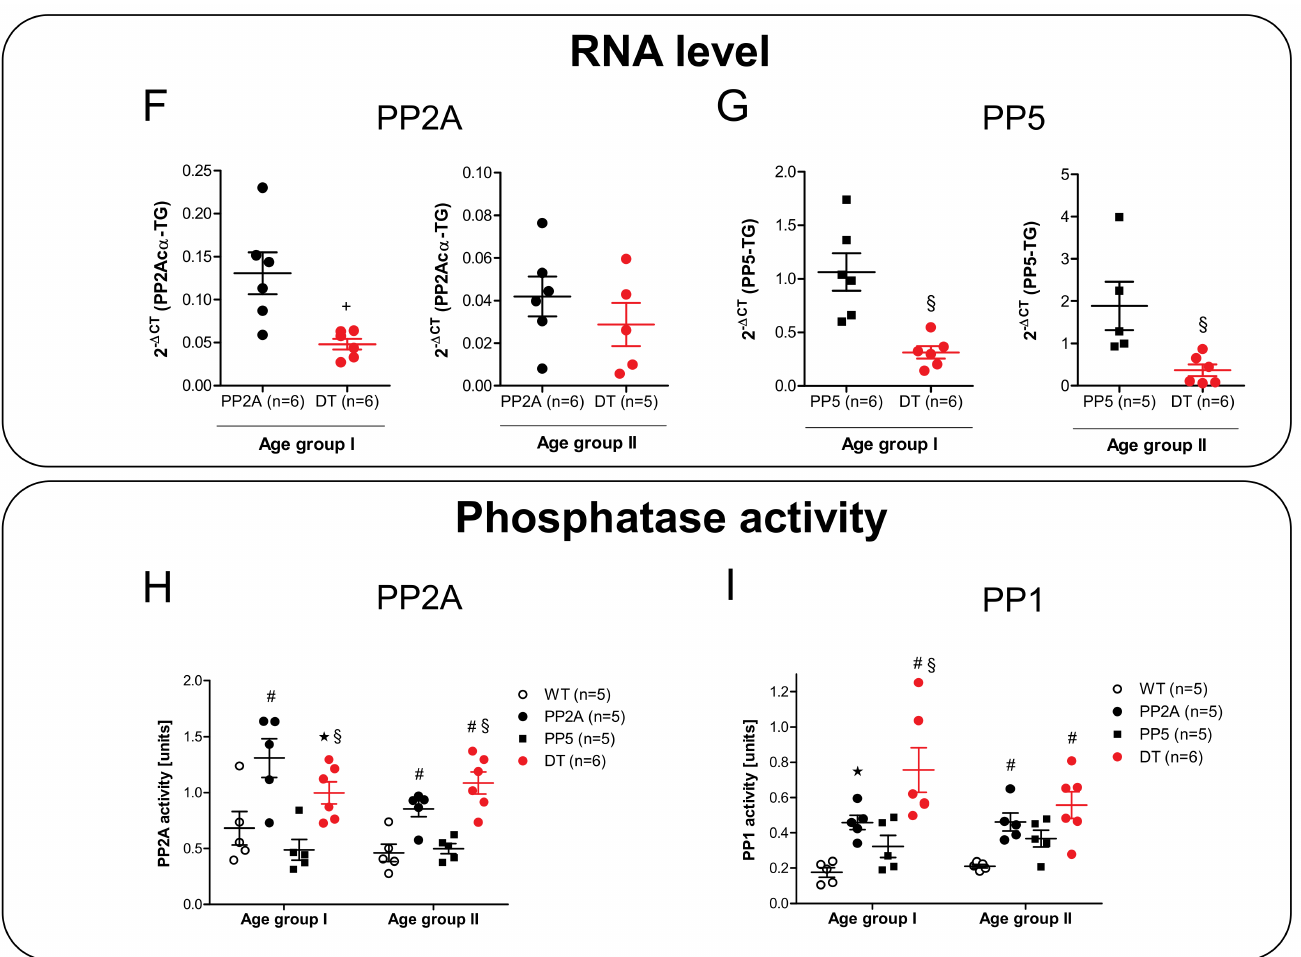
Figure 4. Protein expression of PP2Ac and PP5 in ventricles and left atria of young (age group I) and middle-age (age group II) mice. ( A ): Typical Western Blots, Calsequestrin (CSQ) as loading control; ( B ): PP2Ac-expression in ventricle; ( C ): PP5-expression in ventricle; ( D ): PP2Ac-expression in left atrium; ( E ): PP5-expression in left atrium. mRNA level of PP2Ac and PP5 in ventricles of young and middle-age mice. ( F ): plot of cardiac mRNA density of PP2A in young and middle-age mice, ( G ): plot of cardiac mRNA density of PP5 in young and middle-age mice. Enzymatic activity against phosphorylase a of PP1, PP2A in ventricles of young and middle-age mice. ( H ): Activity of PP2A; ( I ): Activity of PP1. # p < 0.05 vs. WT; + p < 0.05 vs. PP2A; § p < 0.05 vs. PP5; * p < 0.05 vs. WT (Students t -test); n =